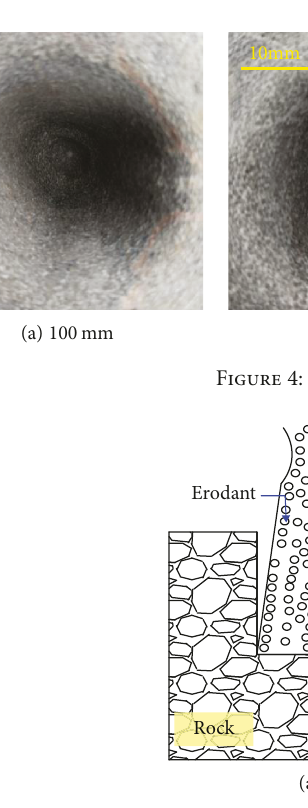
Figure 5: Schematic of the erosion pit feature: (a) is a hypothetical erosion pit feature without considering the rebound abrasive and (b) is a real erosion pit feature considering the re fl ection abrasive.